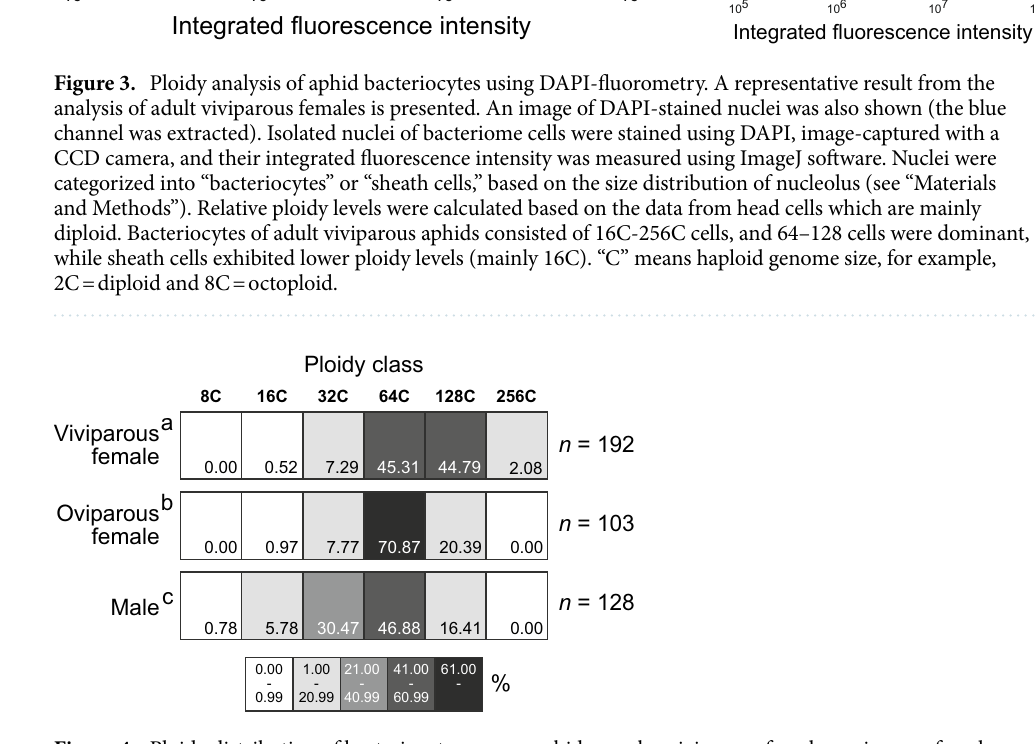
Figure 4. Ploidy distribution of bacteriocytes among aphid morphs, viviparous females, oviparous females, and males. Sample size (numbers of bacteriocyte nuclei) is shown at the right. Different letters with aphid categories indicate significant differences in the median ploidy class (Brunner–Munzel test with Bonferroni adjustment, p < 0.05). Bacteriocytes of adult viviparous females in the pea-aphid were highly polyploid and were mainly 64-128C cells. The cells of oviparous females and males were mainly 64C and 32-64C, respectively. The degree of polyploidy levels was highest in viviparous